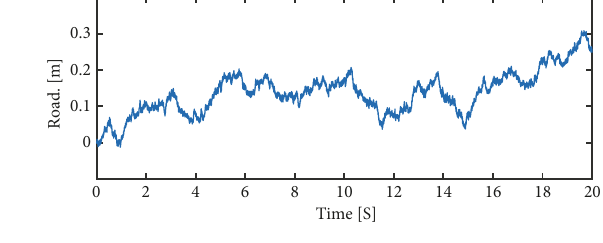
Figure 10: Effective road excitation.